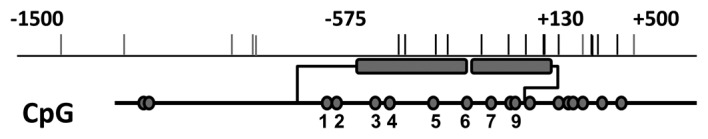
Schematic representation of related to testes-specific, vespid and pathogenesis protein-1 promoter between −1,500 bp upstream and +500 bp downstream of the transcription start site, with each CpG site marked. Grey lines indicate CpG sites that were not detectable by Sequenom, while black lines indicate sites that were detectable. The amplicons assessed are schematically marked by boxes.